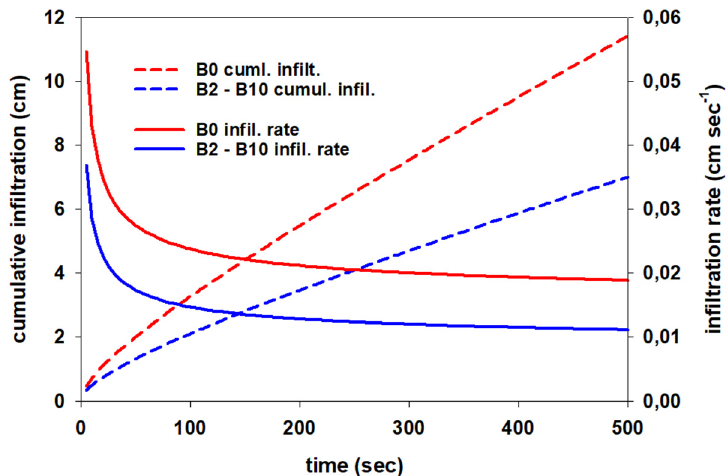
Figure 6. Cumulative infiltration (dashed lines) and instantaneous infiltration rate (solid line) derived from the application of the Philip’s model. Biochar treatments (B2, B4, B6, B8 and B10) were grouped because they were not statistically different from teach other. B0 remained statistically separated from the other